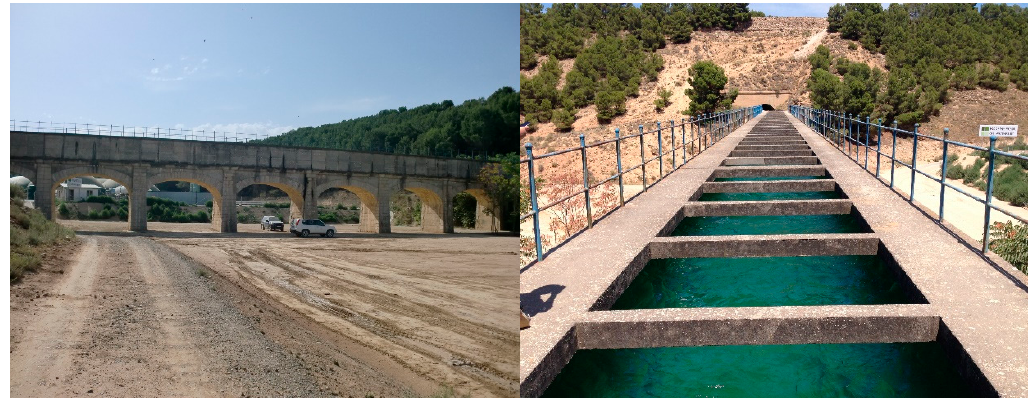
Figure 1. Coll de Foix Aqueduct located in Km 67 of CAyC.